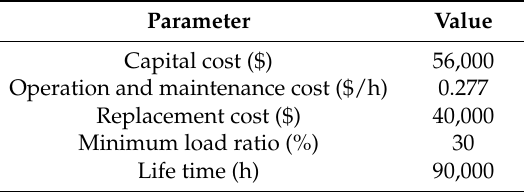
Table 4. Specifications of selected diesel